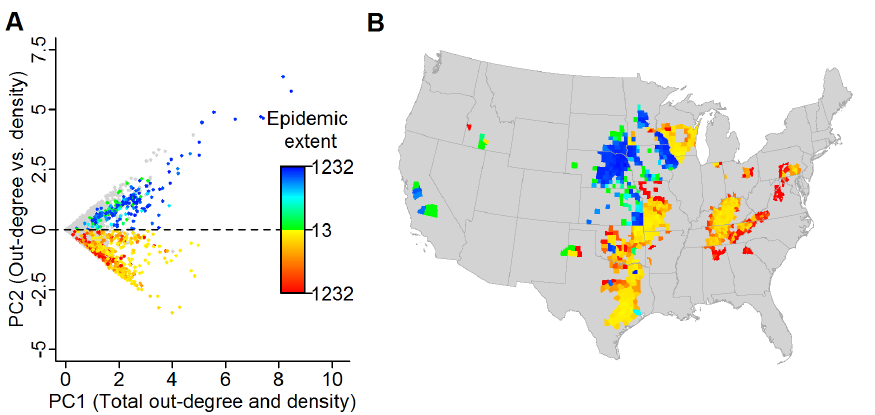
Figure 6. Relative importance of movement vs. local spread determined through a Principal component analysis. (A) Plot of PC1 (0.7071*Out 2 degree + 0.7071*Premises density) vs. PC2 (0.7071*Out 2 degree + 0.7071*Premises density) for each county. Colored dots represent counties in the upper 20% of simulated epidemic extents with the counties where movement is relatively more important (i.e., PC2 . 0) ranging from green to blue and the counties where density is relatively more important (i.e., PC2 , 0) ranging from yellow to red based on epidemic extent. (B) Map depicting the spatial distribution of the counties within the upper 20% of epidemic extents.